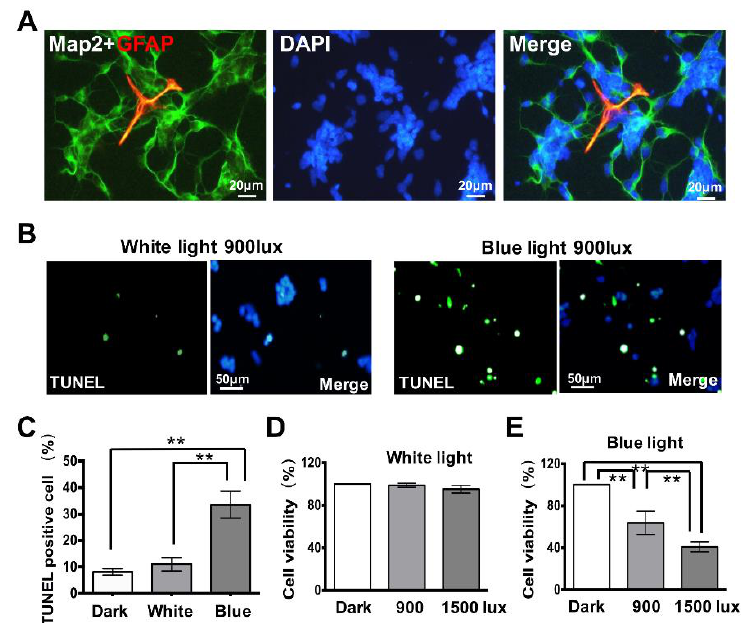
Figure 1. Blue light reduces the viability of retinal neurocytes. ( A ) Double staining for Map2 and glia fibrillary acidic protein (GFAP) in primary cultured retinal neurocytes. ( B ) Terminal deoxynucleotidyl transferase dUTP nick end labeling (TUNEL) assays show blue light exposure induces apoptosis in retinal neurocytes as represented by increased green markers. ( C ) The apoptosis cell number is presented as histogram. ( D ) White light exposure for 2 h at 900 lux or 1500 lux did not affect viability of retinal neurocytes. ( E ) Blue light exposure for 2 h at 900 lux or 1500 lux reduced viability of retinal neurocytes in an illumination-dependent manner. Error bars represent mean ± SD. Asterisks indicate statistically significant differences between control and experimental samples (** p < 0.01).